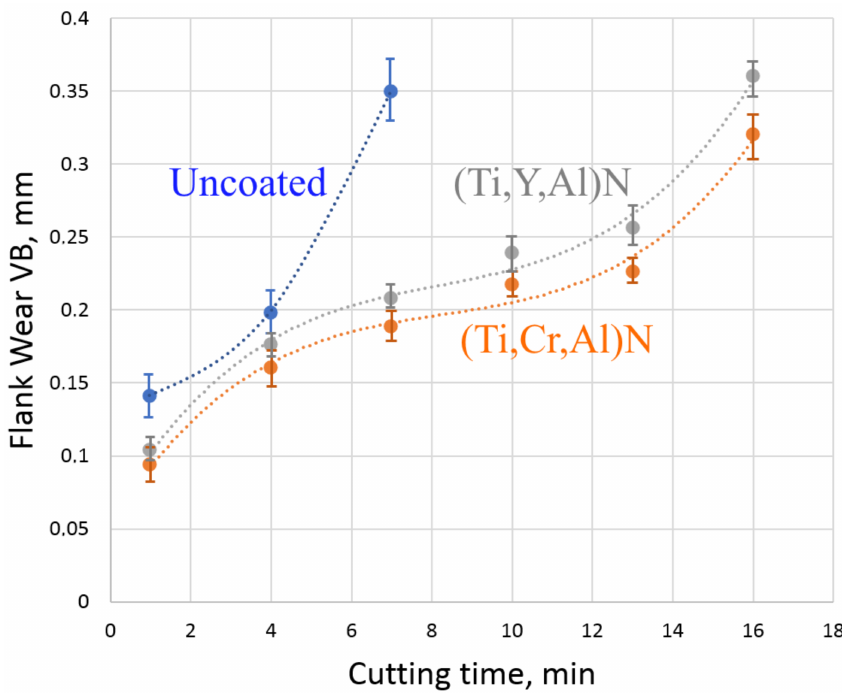
Figure 3. Wear dynamics along the tool flank faces of the tools with the coatings under comparison and the uncoated tools (after 16 min of cutting at f = 0.25 mm/rev, a p = 1.0 mm, and v c = 300 m/min).